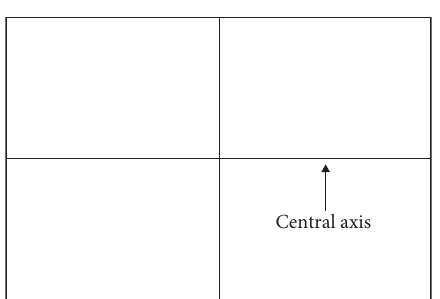
Figure 8: Schematic diagram of central axis in